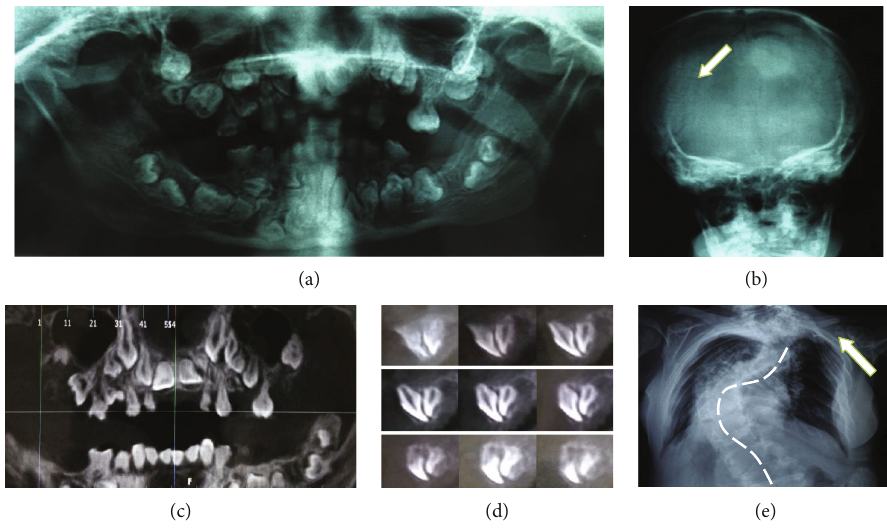
Figure 3: Radiographic evaluation. (a) Panoramic view of the jaws showing multiple unerupted supernumerary teeth. (b) Frontal radiograph showing a delayed closure of sagittal suture and the presence of Wormian bones. (c) Cone-beam radiograph of maxillary and mandibular arches showing a dilacerated root and inverted erupting pathway. (d) Sagittal cone-beam computed tomography section showing an incomplete formation of the left unerupted permanent incisor root. (e) Thorax radiograph showing hypoplasia of the left clavicle.